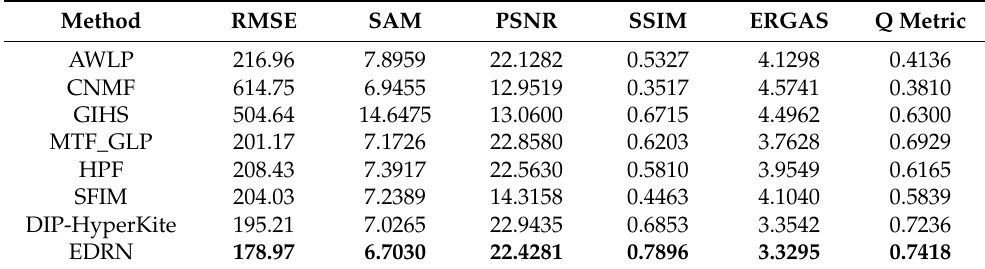
Figure 18. Quality of the compared and proposed fusion methods for the Dianchi dataset: ( a ) SCC; ( b ) spectral curve comparison. Table 3. Quality of the compared and proposed fusion methods for the Dianchi dataset for RMSE, SAM, PSNR, SSIM, ERGAS and the Q